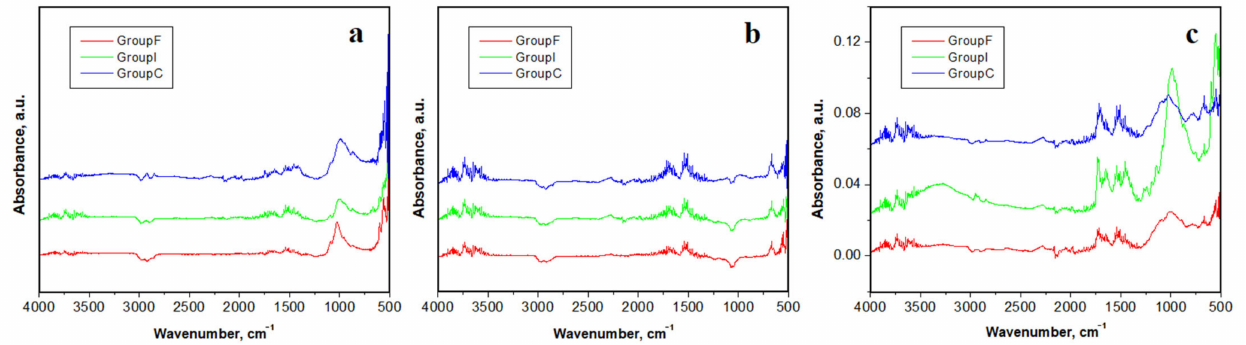
Figure 6. FTIR-ATR spectra for the enamel samples: ( a ) initial untreated, ( b ) after fluorination, and ( c ) after photodynamic laser